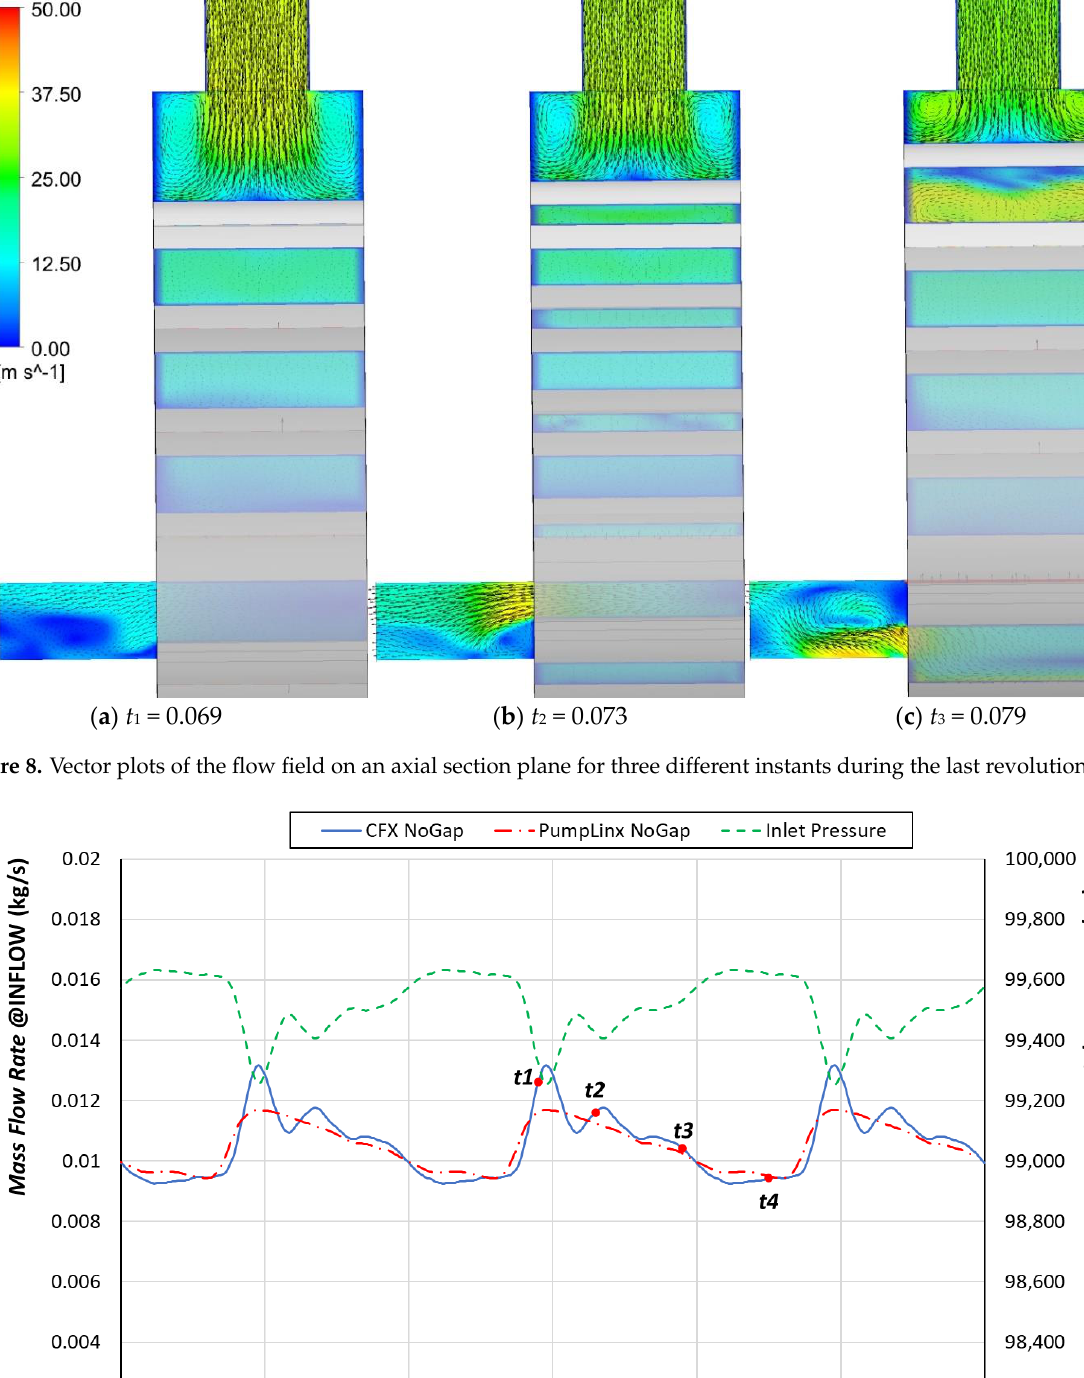
Figure 7. Vector plots of the flow field at mid-span for three different instants during the last revolution (CFX).